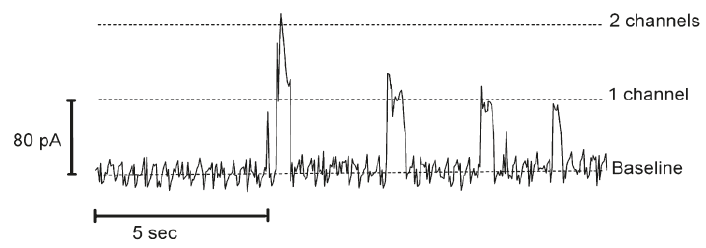
Figure 4. Single-channel current trace in an ABA copolymer membrane upon addition of gramicidin [29]. Trans-membrane potential was 500 mV, and the current traces were filtered at 50 Hz.